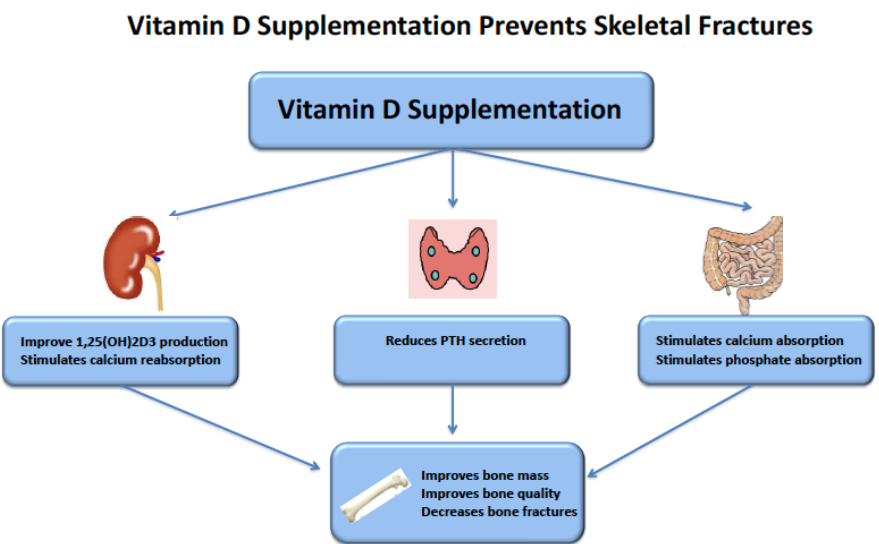
Figure 2. Plausible effects of vitamin D supplementation on skeletal fracture prevention. Natural vitamin D supplementation, either ergocalciferol or cholecalciferol, after their transformation in the